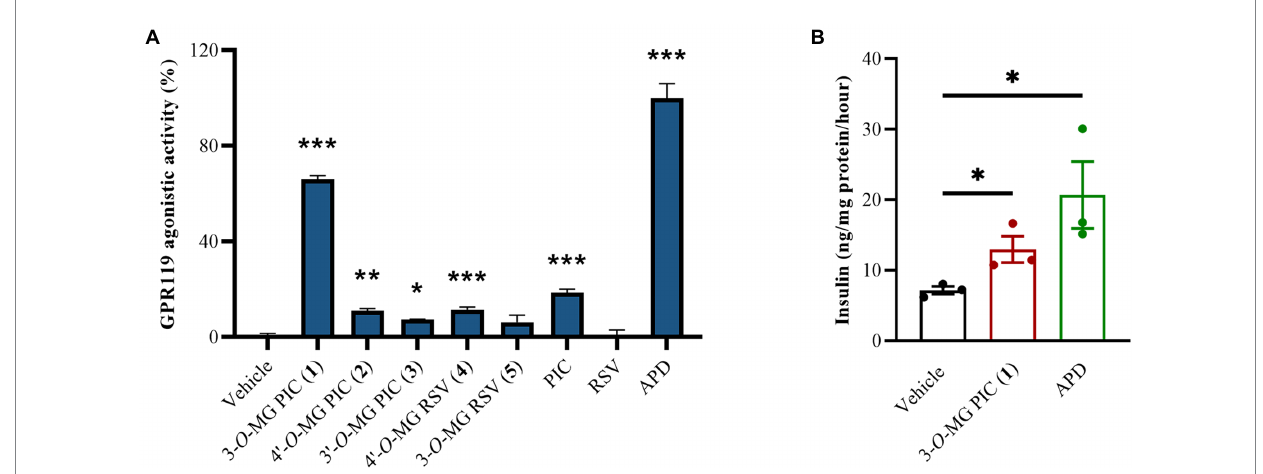
FIGURE 4 (A) GPR119 agonistic activity of two stilbene aglycones (PIC and RSV) and the methylglucosylated derivatives of them ( 1 – 5 ) at 1 μ M in vitro . (B) The effect of 1 on glucose-stimulated insulin secretion. The mouse pancreatic β -cell line MIN6 were cultured in Krebs buffer (containing 16.8 mM glucose) with or without 1 or APD at 1 μ M for 1 h. Vehicle refers to saline. APD refers to the positive control. All data were expressed as the mean ± SEM ( n = 3). * p < 0.05, ** p < 0.01, *** p < 0.001, vs. vehicle group. Data were analyzed by the one-way ANOVA